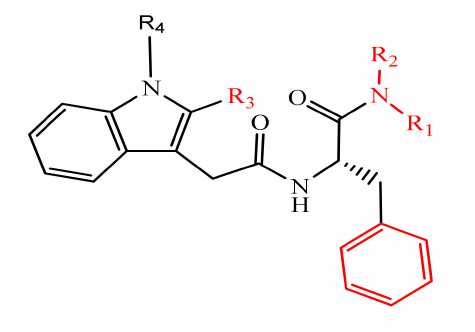
Figure 6. General structure of synthesized